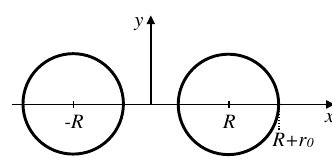
Figure 4. Cross section of a symmetric two-wire arrangement with center distance 2 R and radii r 0